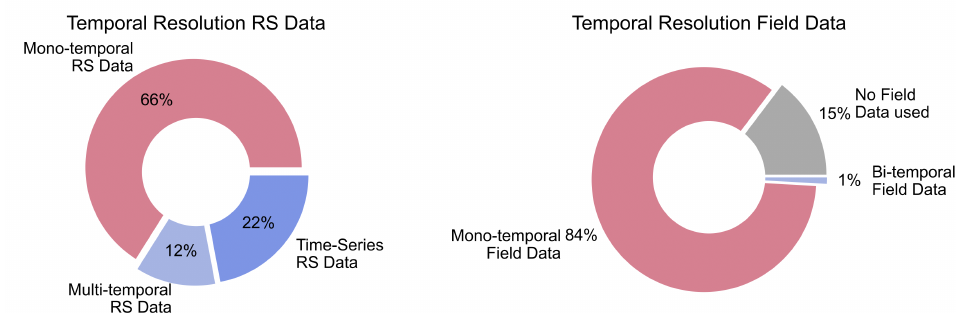
Figure 10. Comparison of the different temporal scales of field and remote sensing